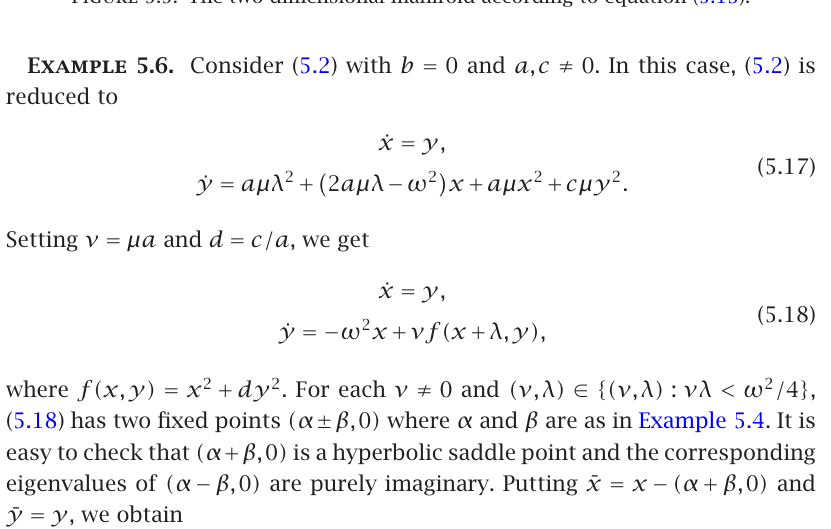
Figure 5.5 . The two-dimensional manifold according to equation